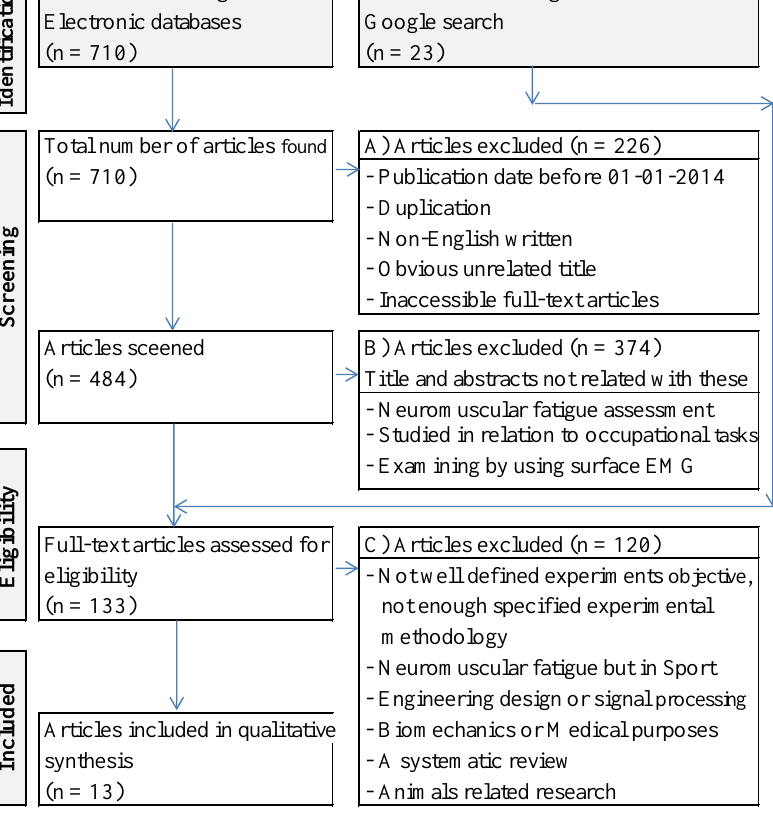
Figure 1. Details of studies selection and inclusion